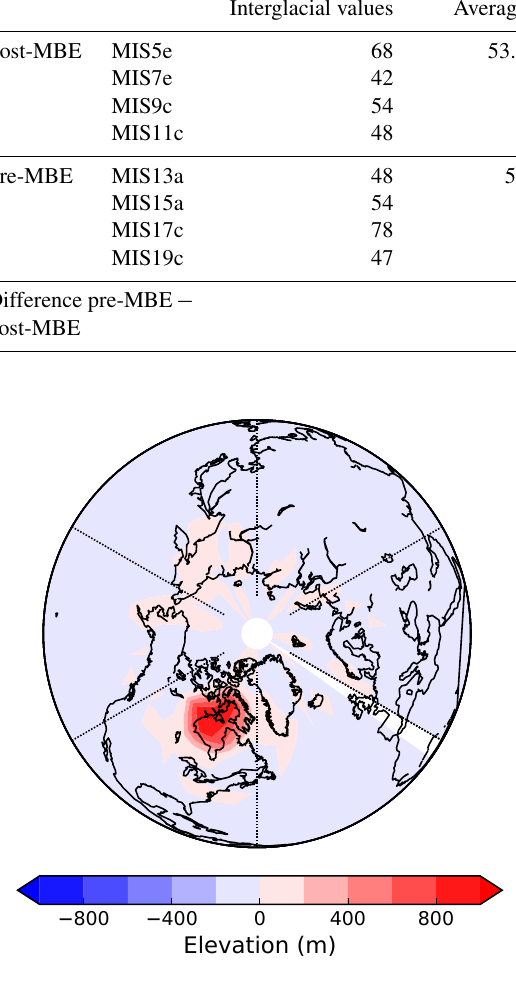
Figure 13. Ice sheet elevation difference (m) between the average of the pre-MBE (MIS 13, 15, 17, 19) and post-MBE (MIS 5, 7, 9, 11) interglacial